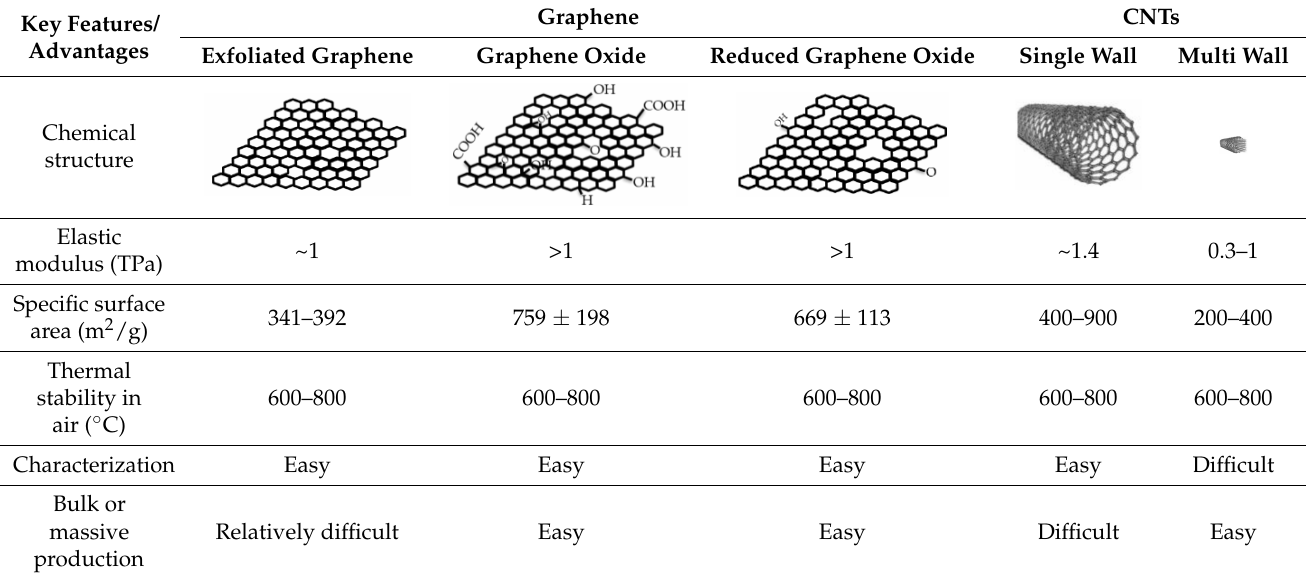
Table 1. Characteristic properties of graphene and CNTs